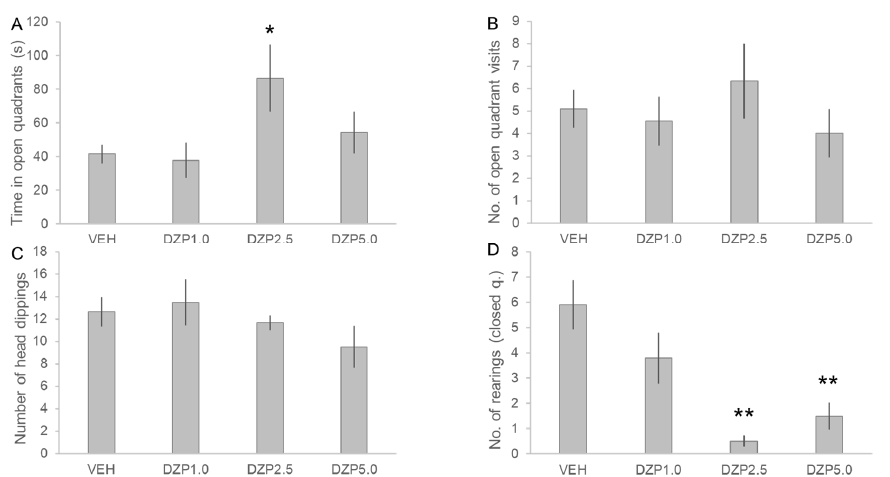
Figure 3. Effects of diazepam on the behavior of rats in the elevated zero maze (EOM) test. Level of anxiety was assessed by measuring the time spent in the open quadrants ( A ), the number of visits to the open quadrants ( B ), and the number of head-dippings ( C ). As an additional variable, the number of rearings in the closed quadrants ( D ) was also counted to assess pharmacological effects of the treatments on the locomotion of the rats. Data are expressed as mean ± SEM. VEH: vehicle,